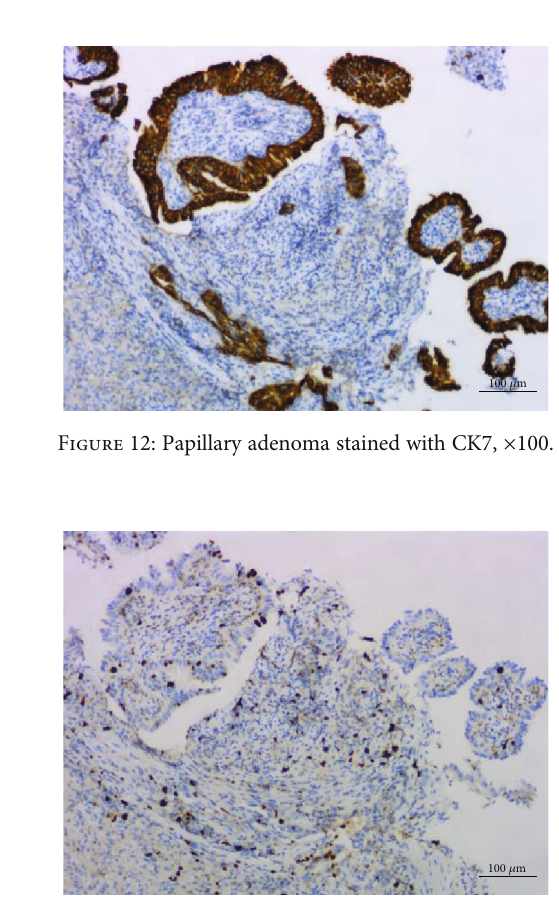
Figure 8: Most of the tumor cells showed simple papillary fronds with fi brovascular cores. Hematoxylin – eosin stain, × 100.